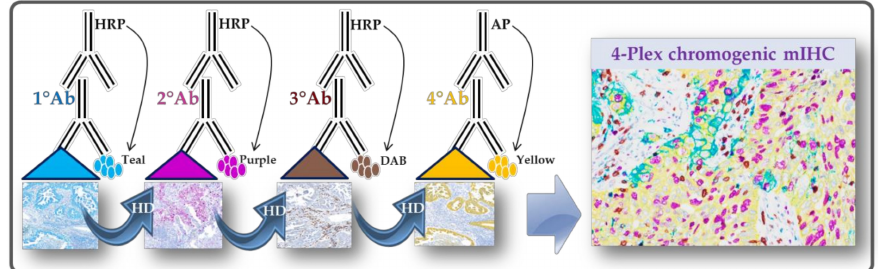
Figure 1. Chromogenic multiplexed immunohistochemistry assay scheme. The assay is using the sequential application of four unmodified primary antibodies with a specific heat deactivation (HD) step between staining